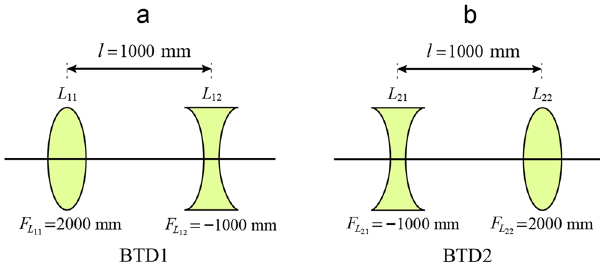
Fig. 6 Beam transformation devices (BTD). a Con fi gurations of BTD1. b Con fi gurations of